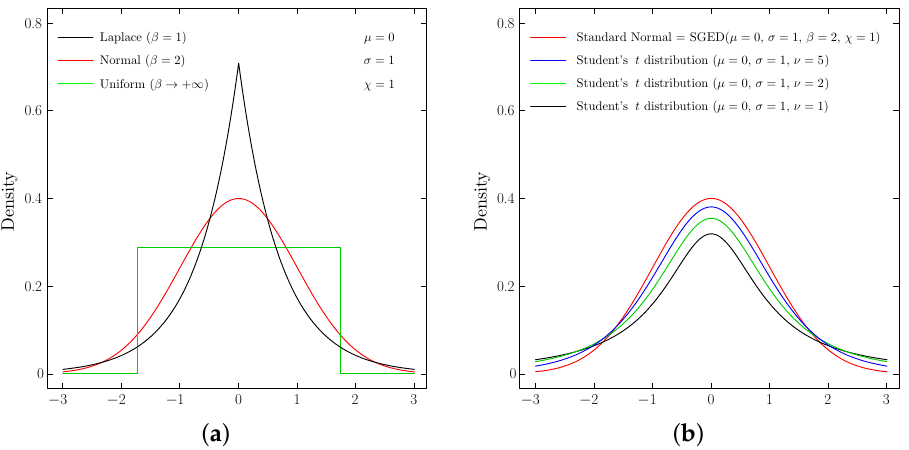
Figure 4. SGED ( µ , σ , β , χ ) and Student’s t distribution. Notes: In ( a ), we show three special cases of SGED: Laplace distribution (black) when β = 1, standard normal distribution (red) when + ∞ . Generally, if β < 2, then the distribution β = 2, and uniform distribution (green) when β → is leptokurtic, with heavier tails and a peak more acute and higher than in normal distribution. In ( b ), we compare normal distribution with Student’s t distribution. As the number of degrees of freedom ν increases, Student’s t distribution approaches normal distribution. ( a ) Special cases of SGED; ( b ) normal and Student’s t distributions. Source: Author’s